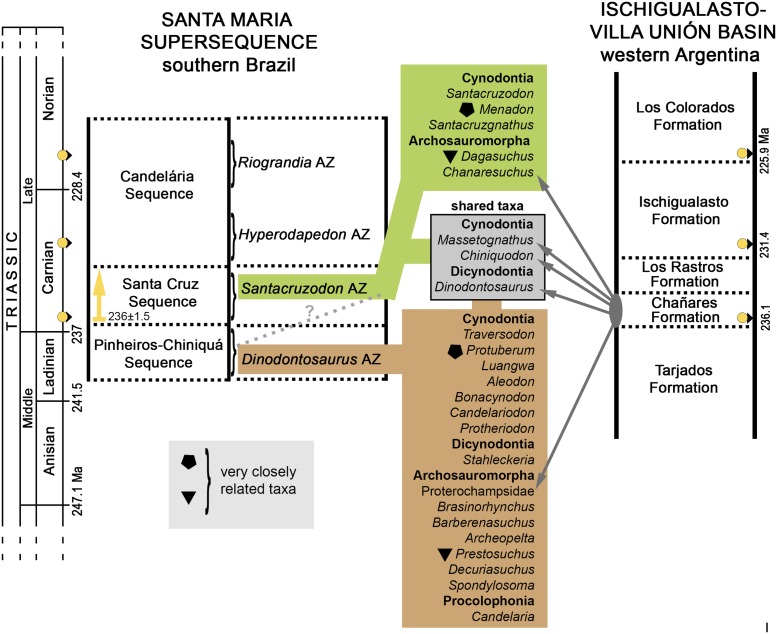
Biostratigraphy of the Dinodontosaurus and Santacruzodon AZs.Tetrapod fossil comparisons and shared taxa with the Chañares Formation of western Argentina. The ages of the column follow Gradstein et al. [36]. The radiometric dating of 236.1, 231.4 and 225.9 Ma on the Ischigualasto-Villa Unión Basin column correspond to the first half of the Chañares Formation [45], the base of the Ischigualasto Formation, and the base of Los Colorados Formation [105], respectively, and the one in the Santacruzodon AZ follows Philipp et al. [43].